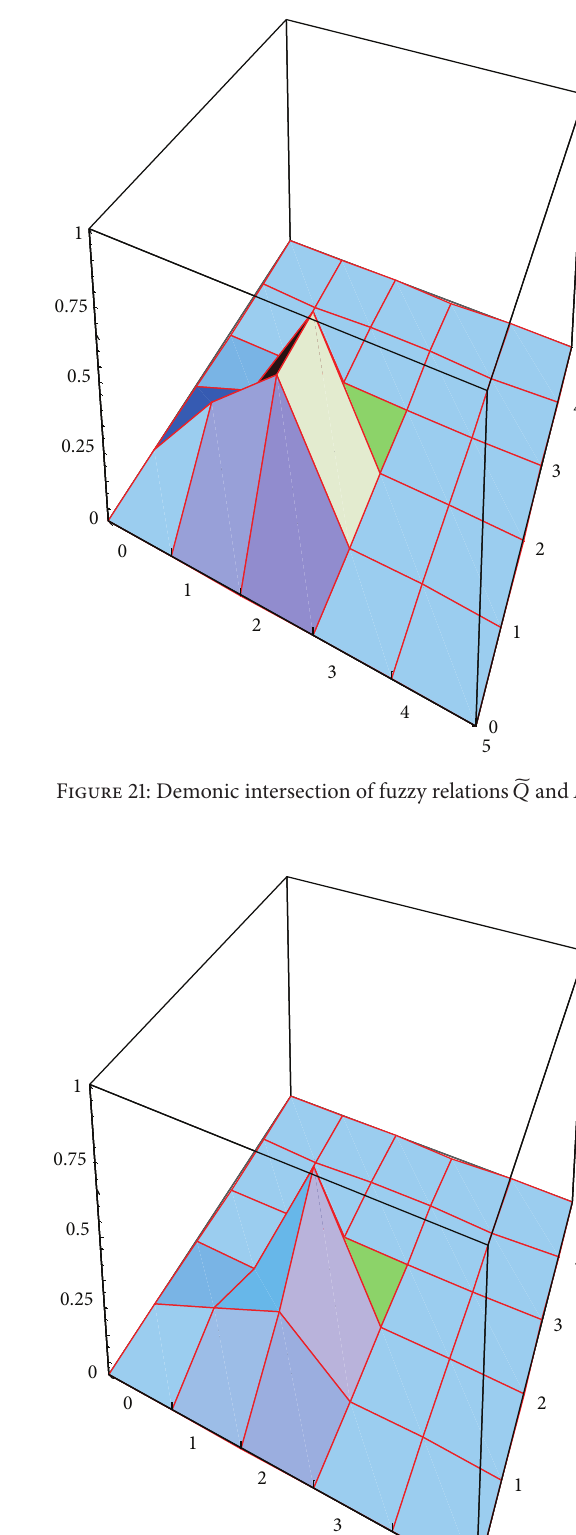
Figure 20: Angelic union of fuzzy relations